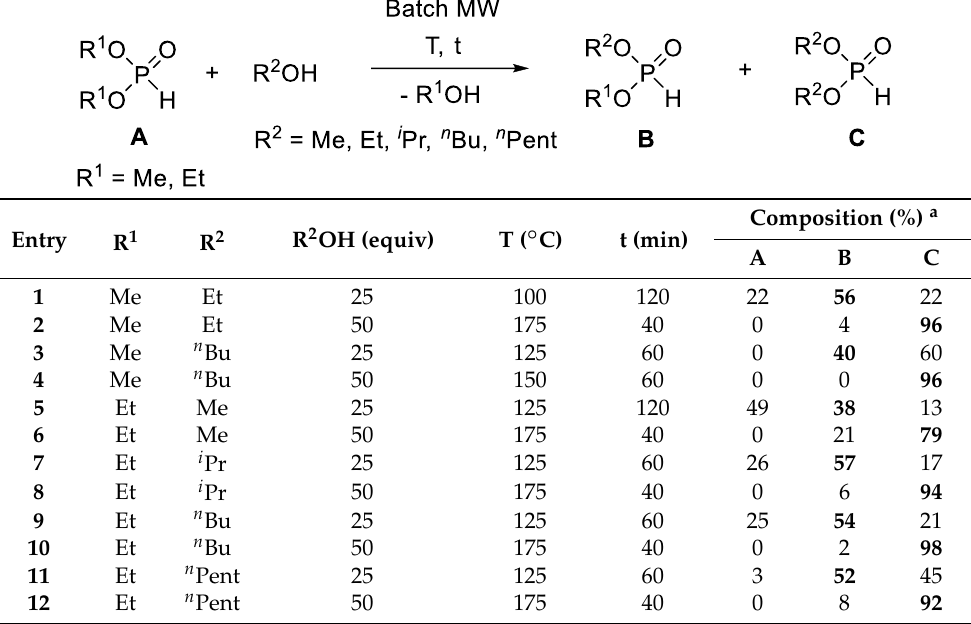
Table 2. Alcoholysis of dialkyl H -phosphonates in a batch microwave (MW) reactor [33].